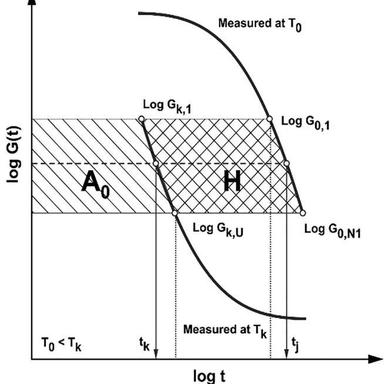
Schematics of the CFS procedure for an example of shear relaxation modulus (G(t)).